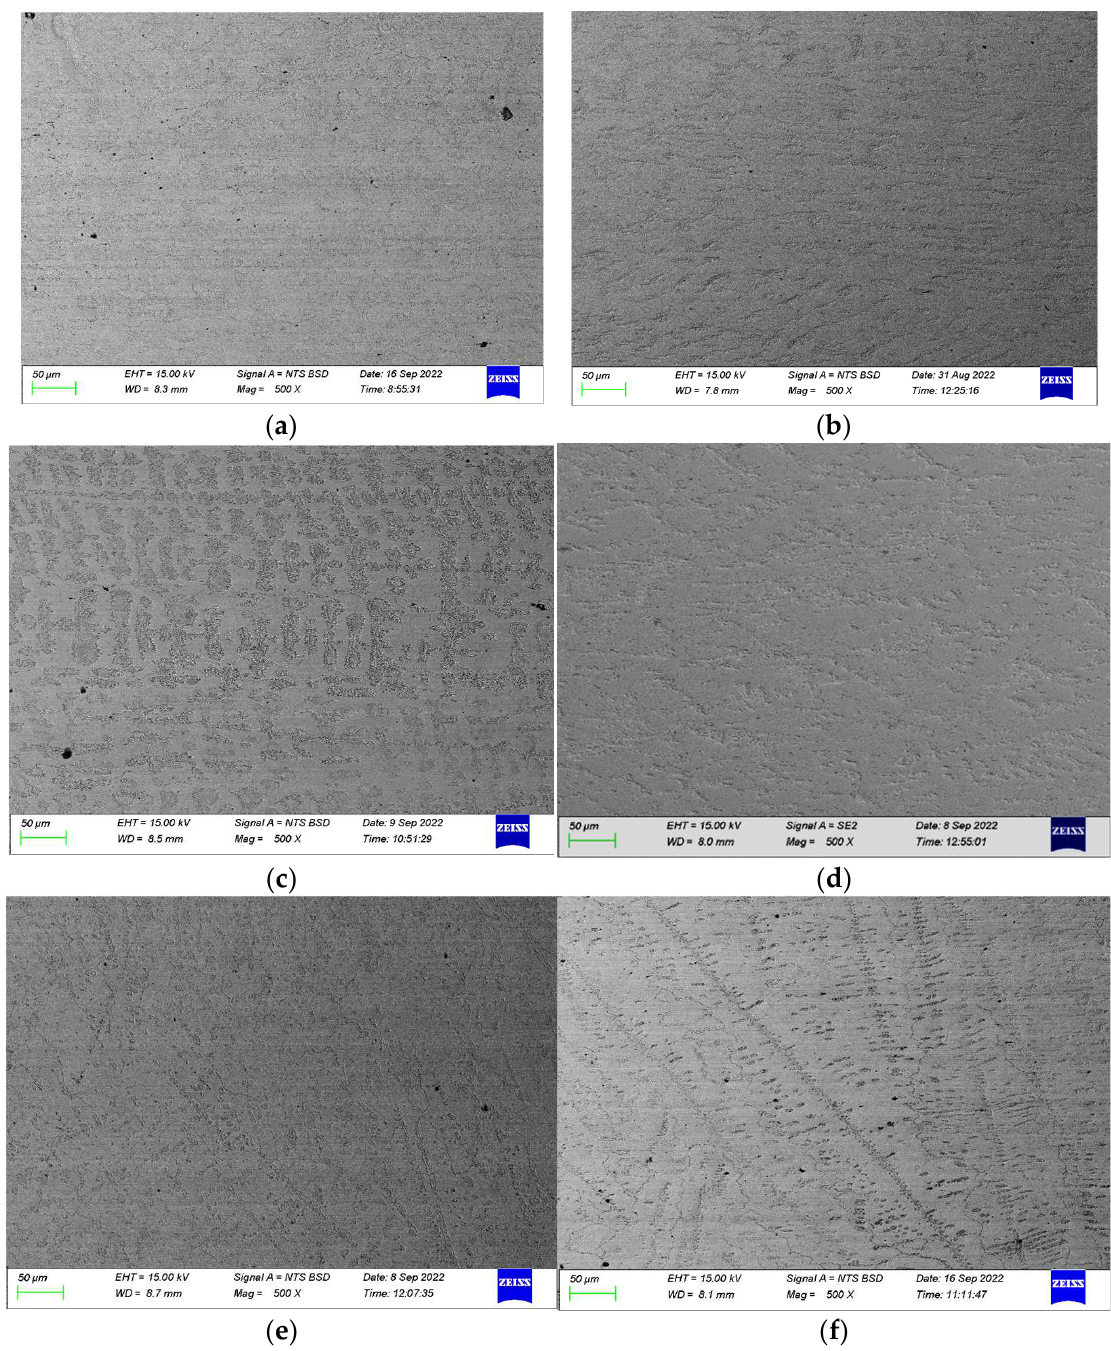
Figure 11. Scanning electron microscope images of deformed Fe-21.3Mn-7.6Al-4.3Cr-1C under different deformation conditions: ( a ) 800 °C at 0.1 s −1 ; ( b ) 800 °C at 5 s −1 ; ( c ) 900 °C at 0.1 s −1 ; ( d ) 900 °C at 5 s −1 ; ( e ) 1000 °C at 0.1 s −1 ; ( f ) 1000 °C at 5 s −1 .